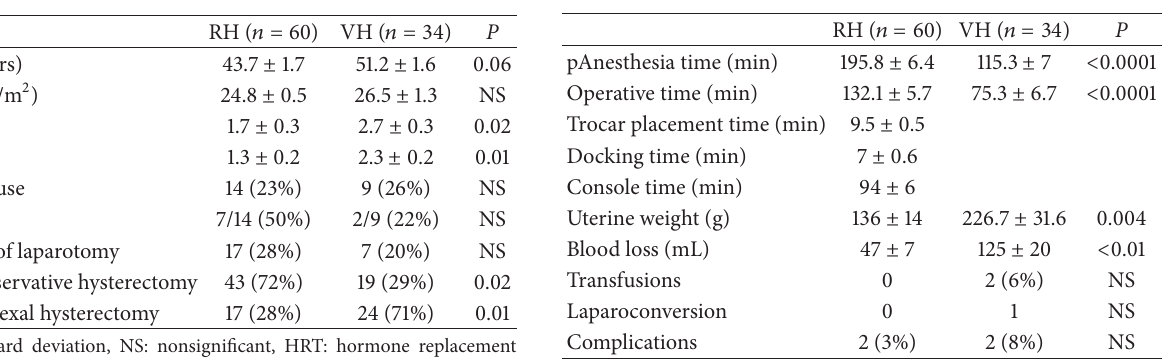
Table 1: Demographics and characteristics of the population expressed as mean ± SD and number (%).